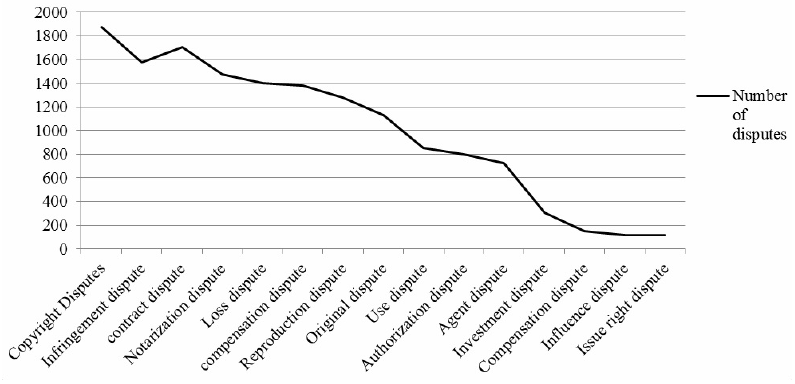
Fig. 1 Types and quantity distribution of original music copyright disputes from 2010 to